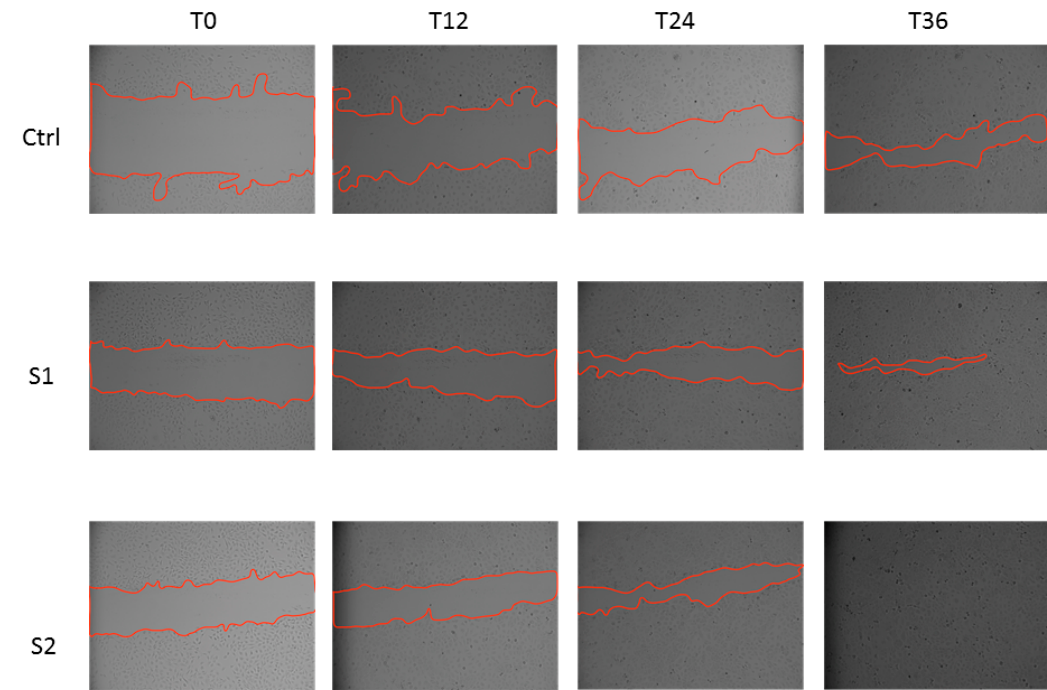
Figure 2. In vitro wound healing assay of human corneal epithelial cells. After the scratch, HCEpiC cells were incubated in fresh medium with or without S1 and S2 for 36 hours. Representative images from each group were recorded at 0, 12, 24 and 36 hours post-scratching. The red lines indicate the wound borders.